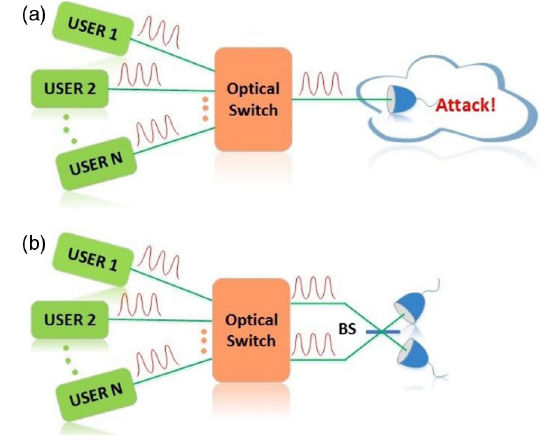
FIG. 1. (a) Schematic of a conventional QKD network with detectors as the shared resources, which are vulnerable to detection attacks. (b) Schematic of star-type MDIQKD network, in which the shared detectors can even be controlled by Eve but without any leakage of key